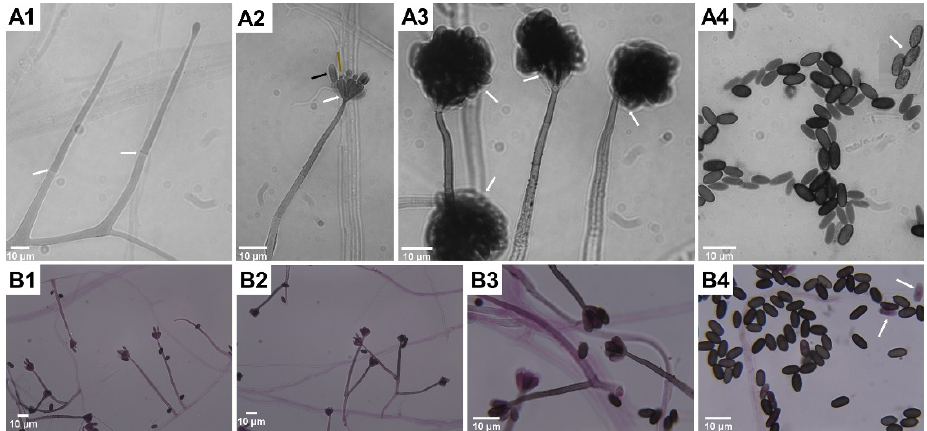
Figure 2. According to the literature [12,13,31,34,35,37,57], these images represent Stachybotrys chartarum -specific mycelial structures typical for anamorphs visualized in light microscopy (saline wet mount microscopy, ( A1 – A4 ); fungal structures stained by lactofuchsin, ( B1 – B4 )). Successive stages of development of mycelial structures: single, erect and septate (white arrows) conidiophores formation ( A1 ); forming inverse bottle-shaped phialides (white arrow) with the apex (brown arrow) on top of conidiophore, successively produced single phialoconidia (black arrow, ( A2 )) clustered in slimy heads (white arrows, ( A3 )), which, when dried, release conidia ( A4 ) with a rough surface (white arrow). Characteristic for S. chartarum formation of sympodially branched conidiophores ( B2 , B3 ), and less often formed solitary conidiophores ( B1 ), release mature conidia that are black in color as opposed to immature conidia that easily absorb dye (white arrow, ( B4 )). Magnification 1000× ( A1 – A4 , B3 , B4 ) and 400× ( B1 , B2 ), scale bars 10 μ m. Photos by the author.